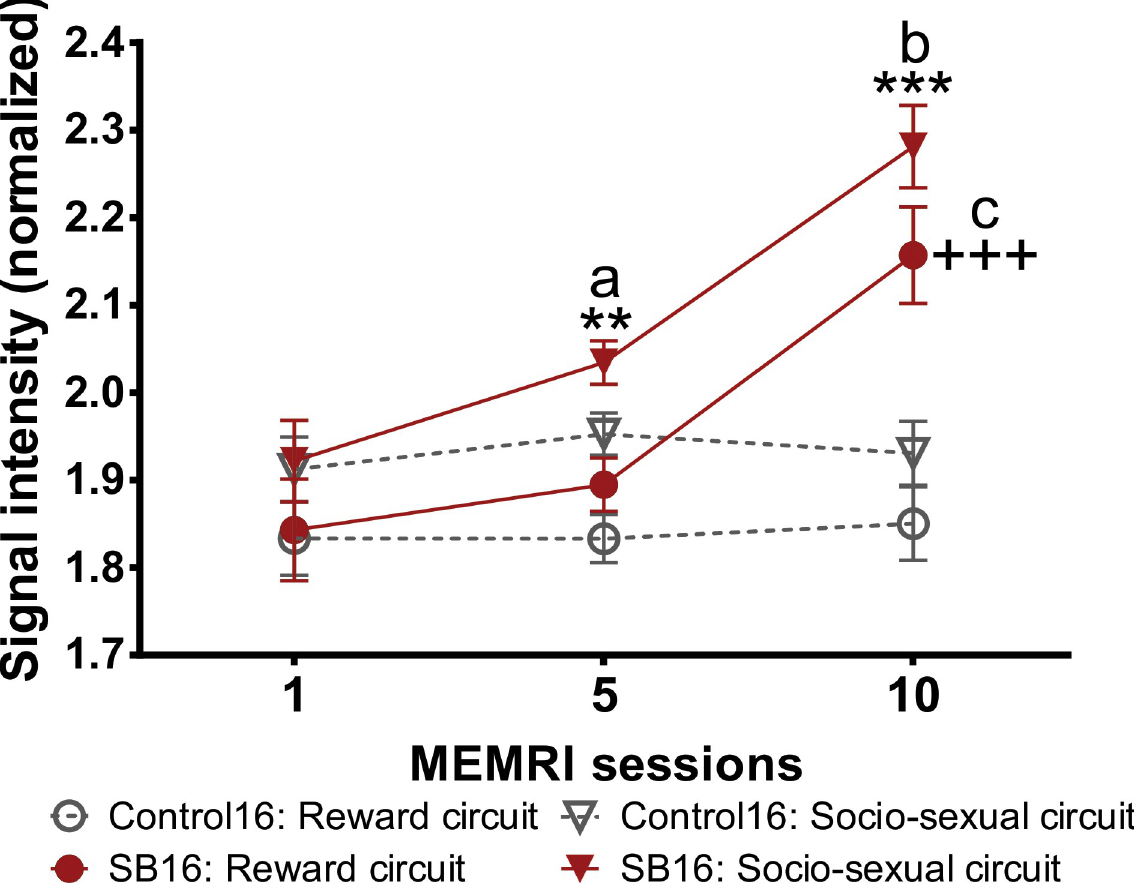
Fig 9. Signal intensity in the socio sexual behavior and reward circuits in the control and in the group that paced the sexual interaction after treatment with 16 mg/kg of MnCl 2 . Data are expressed as mean ± SEM. �� Socio-sexual circuit, different from control and reward circuit in the same session p < 0.01; ��� , p < 0.001. +++ Reward circuit different form its control, p < 0.001. a Socio-sexual circuit, different from session 1, p < 0.001. b Socio-sexual circuit, different from session1 and 5, p < 0.01. c Reward circuit, different from session 1 and 5, p < 0.001.